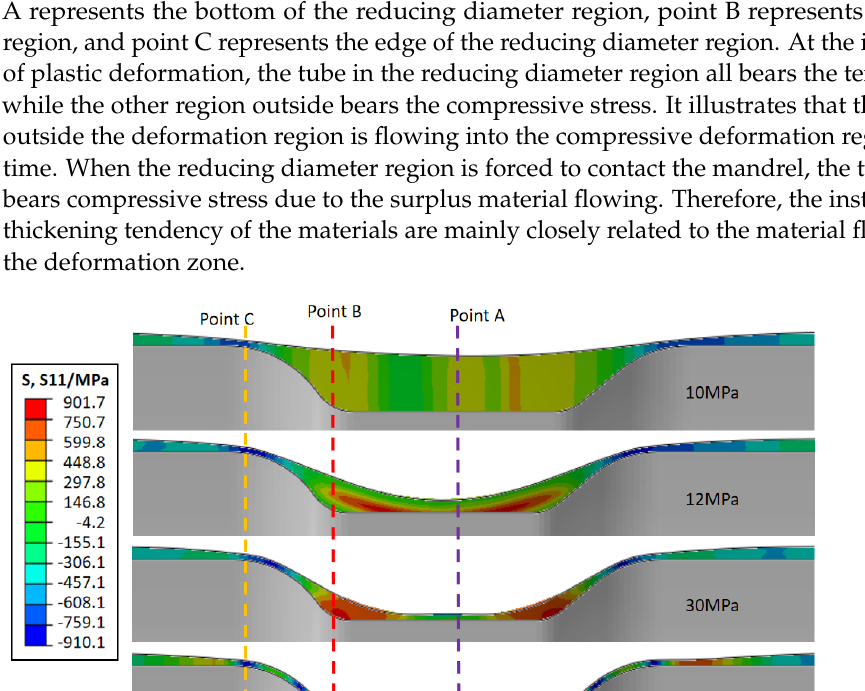
Figure 14. The thickness distribution of the compressive deformation region during different periods: ( a ) initial time of deformation and ( b ) end time of deformation.